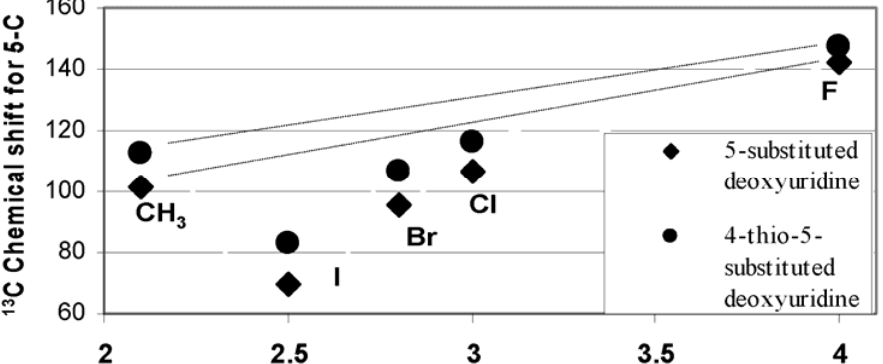
Figure 2. 13 C chemical shift of the atom (group) at 5-C plotted against its electro